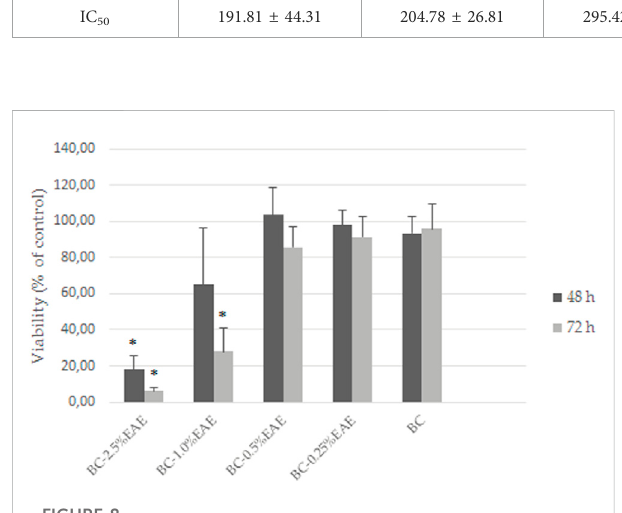
TABLE2TheIC 50 values( μ g/mL)weredeterminedusingPrestoBlueassayafter48 hoftreatment.Dataareexpressedasmean±SDfromatleastthreeindependent experiments. Cell line